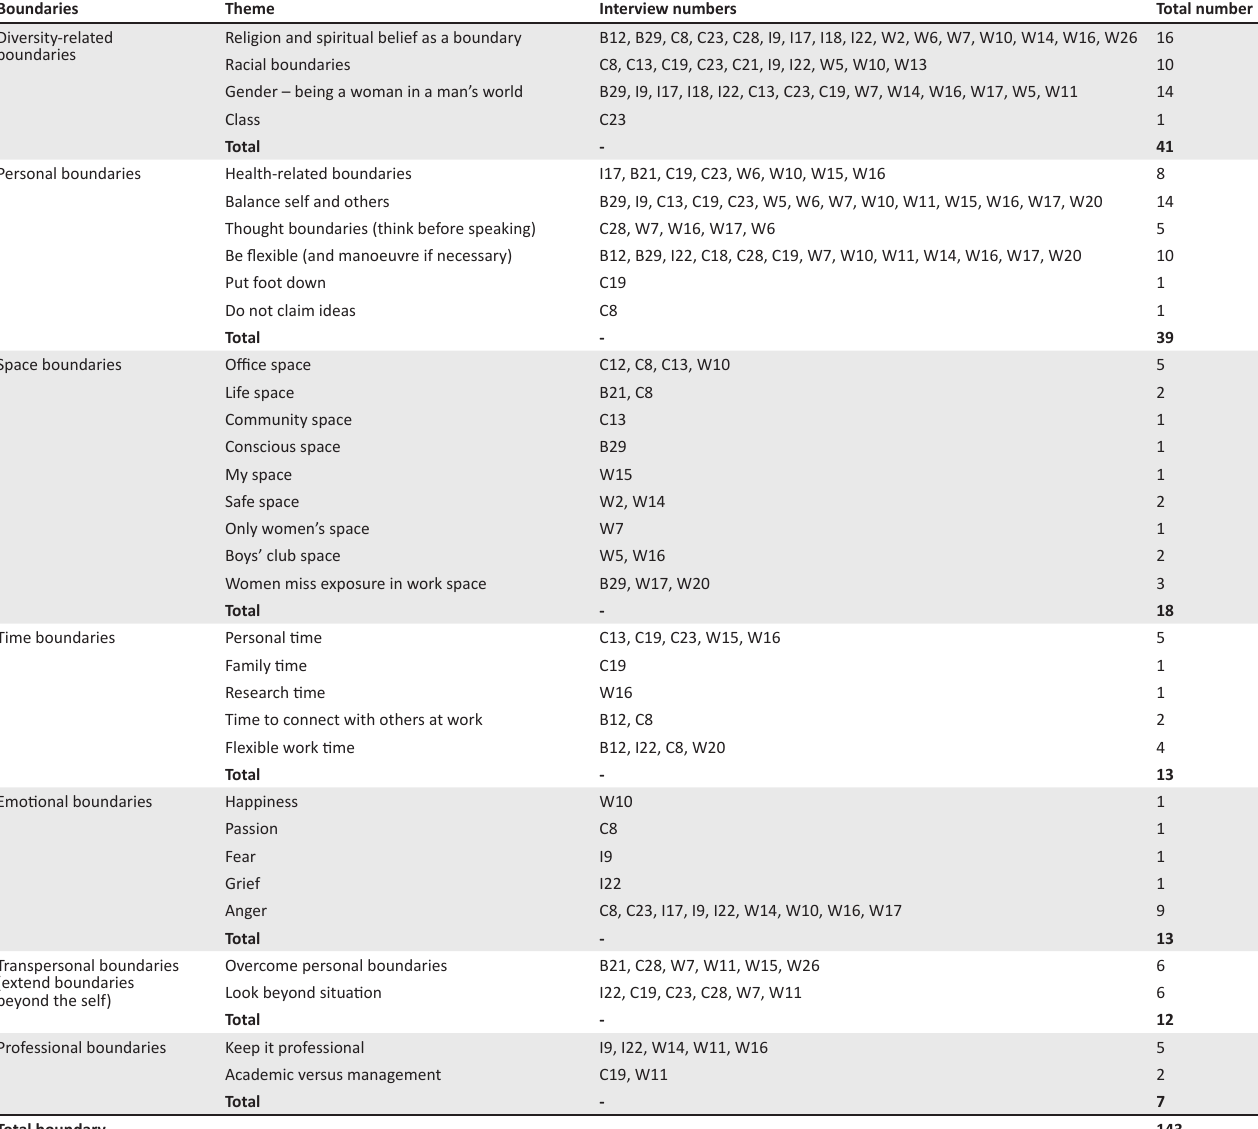
TABLE 6: Boundaries of women leaders.